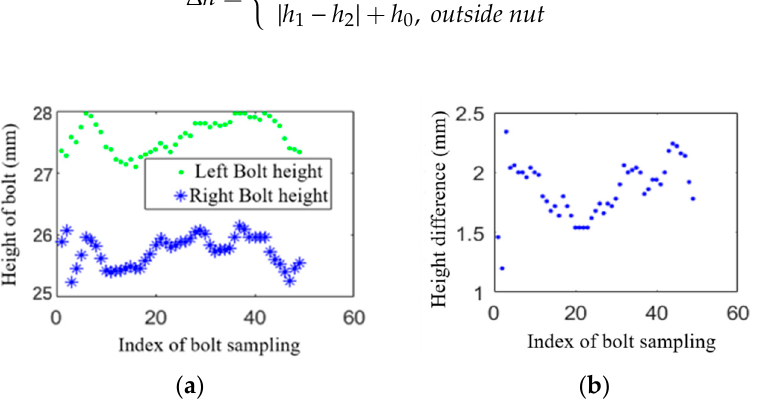
Figure 14. ( a ) Height of left bolt and right bolt; ( b ) height difference between left and right rail bolts.